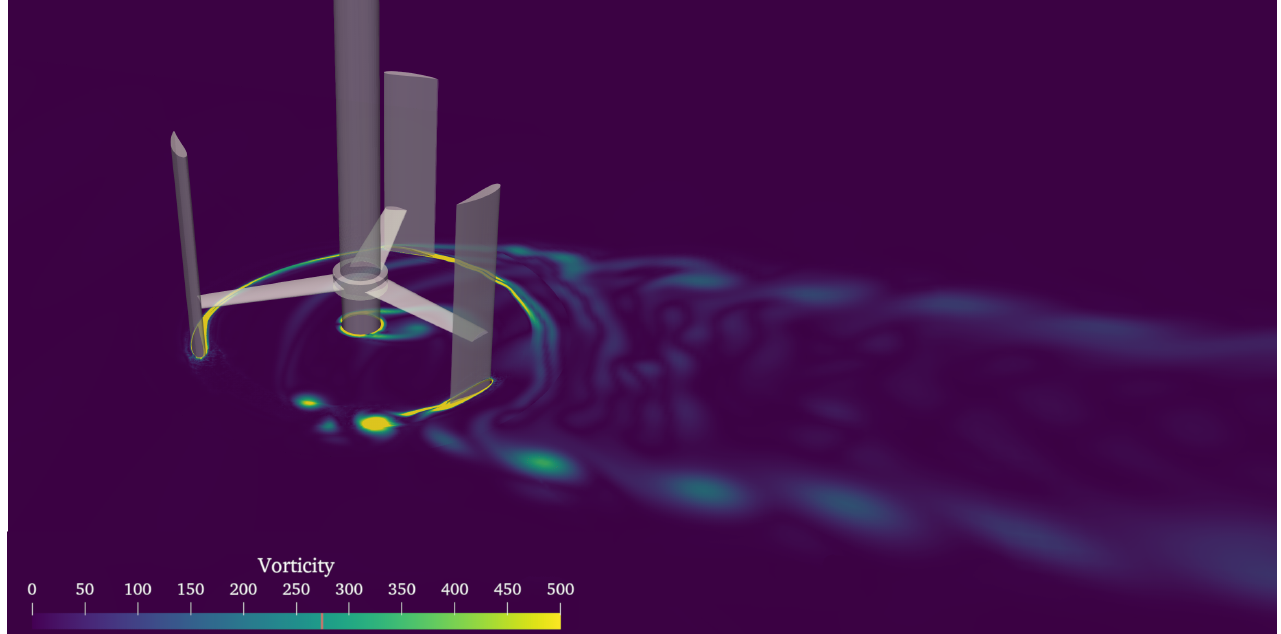
Figure 1. Three-dimensional computer-aided design (CAD) model of a three-bladed H-Darrieus cross-flow tidal turbine (CFTT) and vorticity field from numerical investigations at tip-speed ratio λ = 2. CFTTs generate a complex flow field due to the cross-flow design and the lack of a guiding structure (Software package